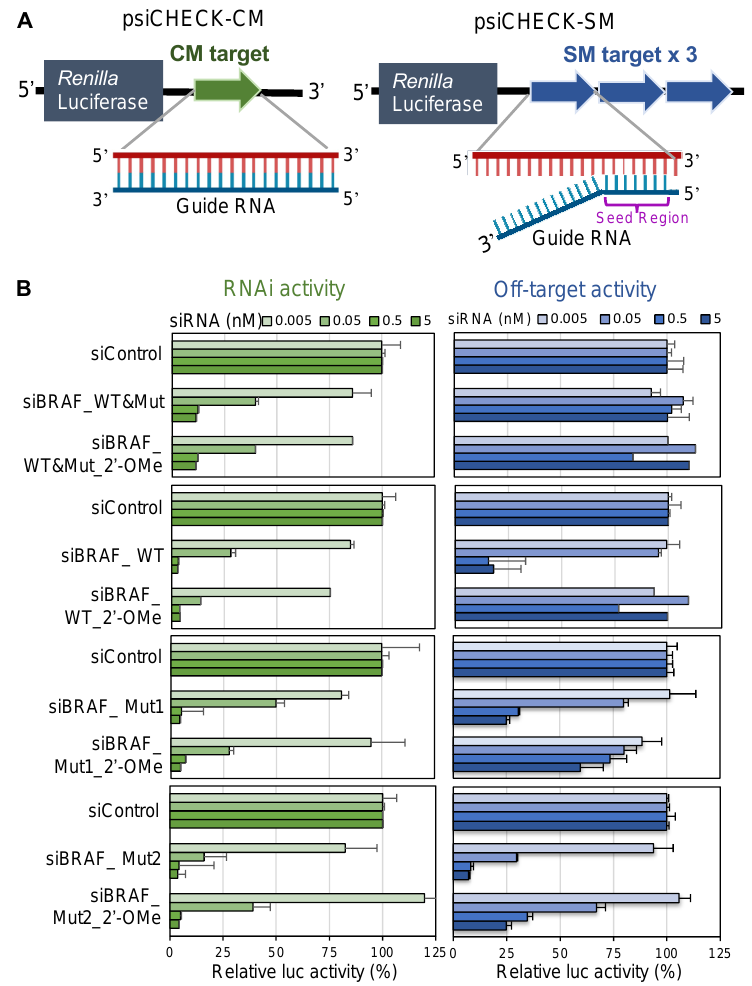
Figure 3. RNAi and off-target activities of each siRNA targeting BRAF in HeLa cells determined by dual luciferase reporter assays. ( A ) The structures of CM (RNAi) or SM (off-target) reporter constructs. ( B ) The CM (RNAi) or SM (off-target) reporter constructs were transfected with an siRNA along with the pGL3-Control firefly luciferase expression construct into HeLa cells, and luciferase activity was measured 1 day after transfection. The RNAi and off-target activities were calculated as Renilla luciferase activity normalized to control firefly luciferase activity. RNAi (left, green bars) and off-target activities (right, blue bars) for four siRNA concentrations (0.005, 0.05, 0.5, and 5 nM). The horizontal bars indicate the relative luciferase activity levels. The results indicate the averages of 3 independent experiments.